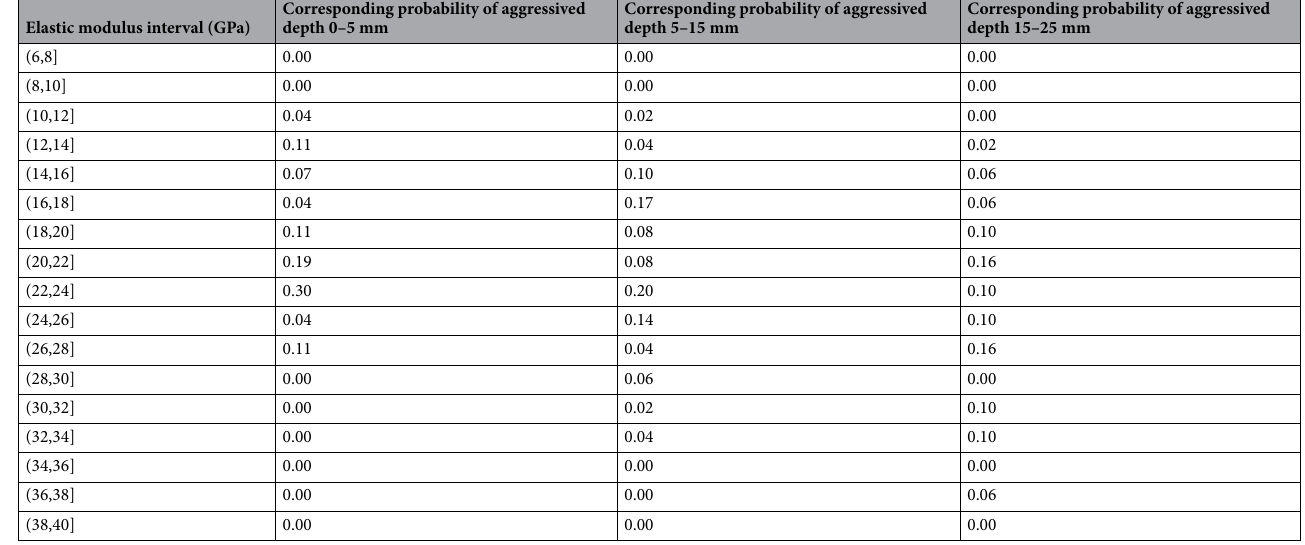
Table 5. Probability distribution of the elastic modulus at different aggressived depths for group